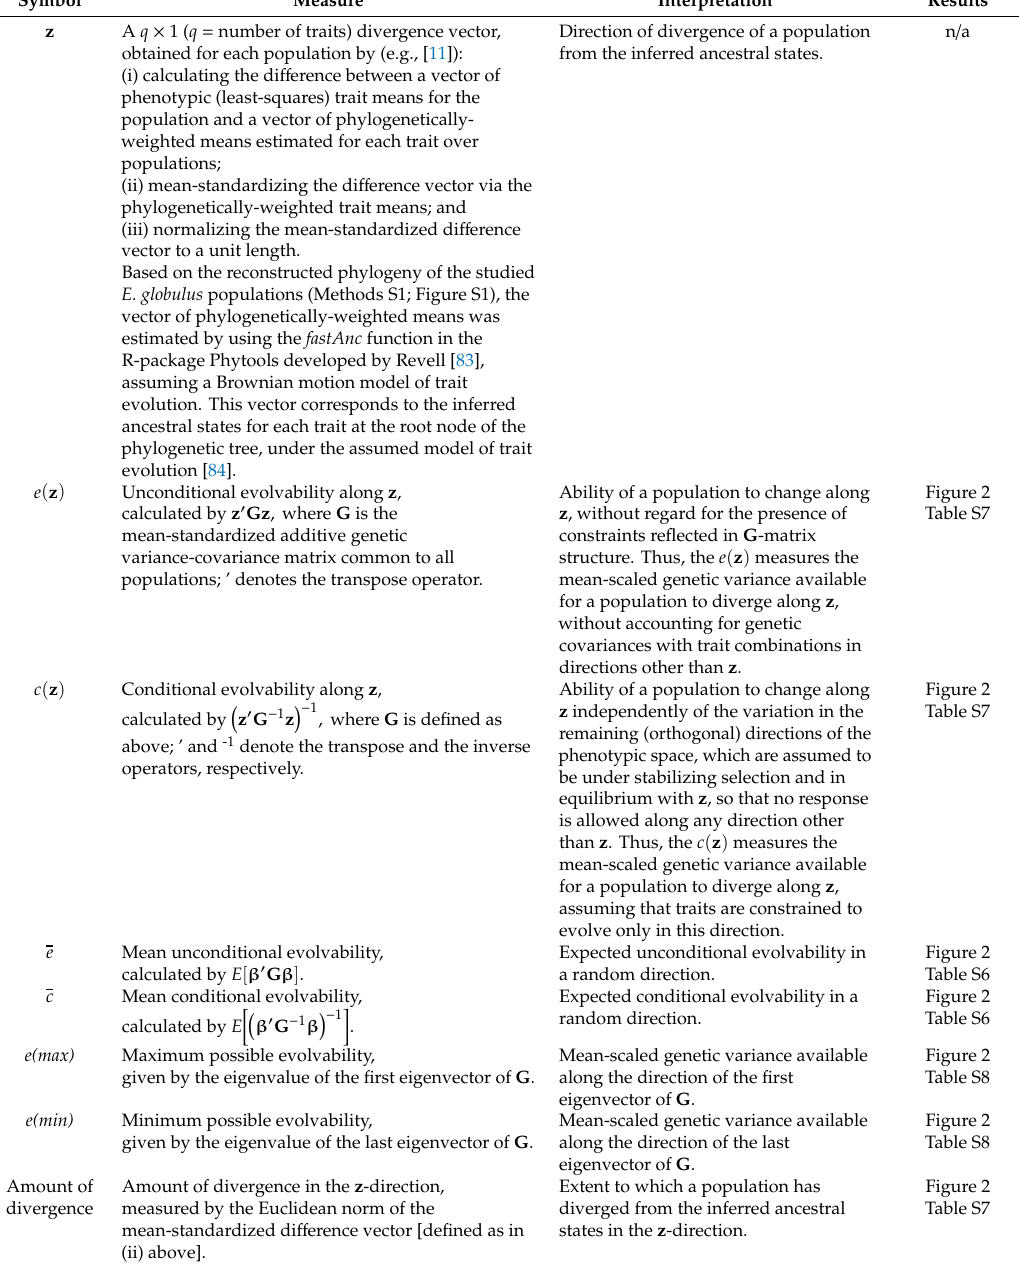
Table 2. Measures used to assess the influence of intra-specific genetic (co)variation on the evolutionary trajectory of a population and its divergence from other populations. Symbol Measure Interpretation Results z Direction of divergence of a population n / a from the inferred ancestral states.